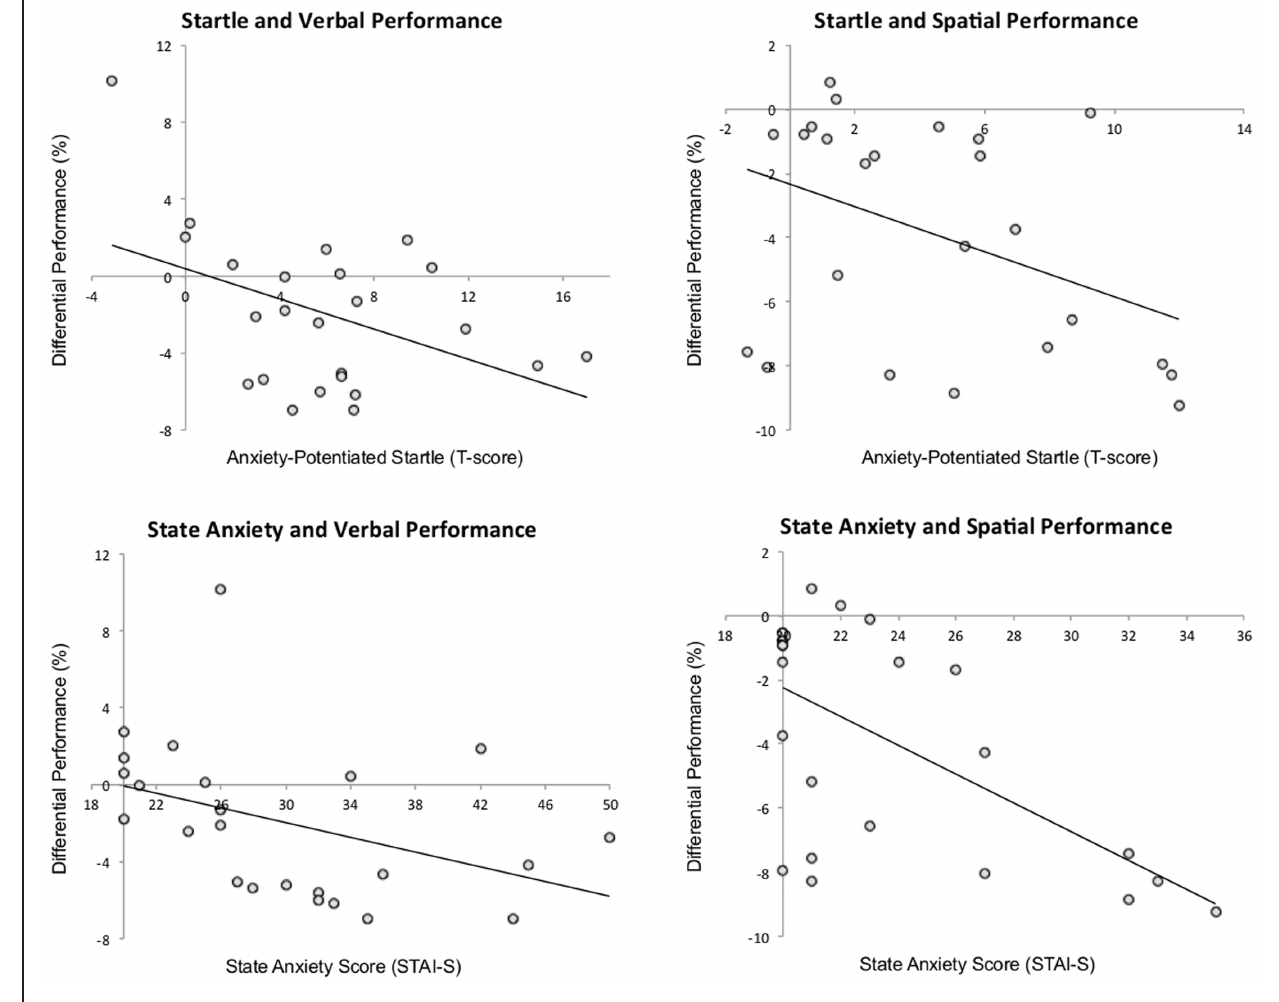
FIGURE 3 | The relationship among anxiety-potentiated startle, performance (threat–safe), and state anxiety. Startle potentiation was negatively correlated with verbal and spatial working memory